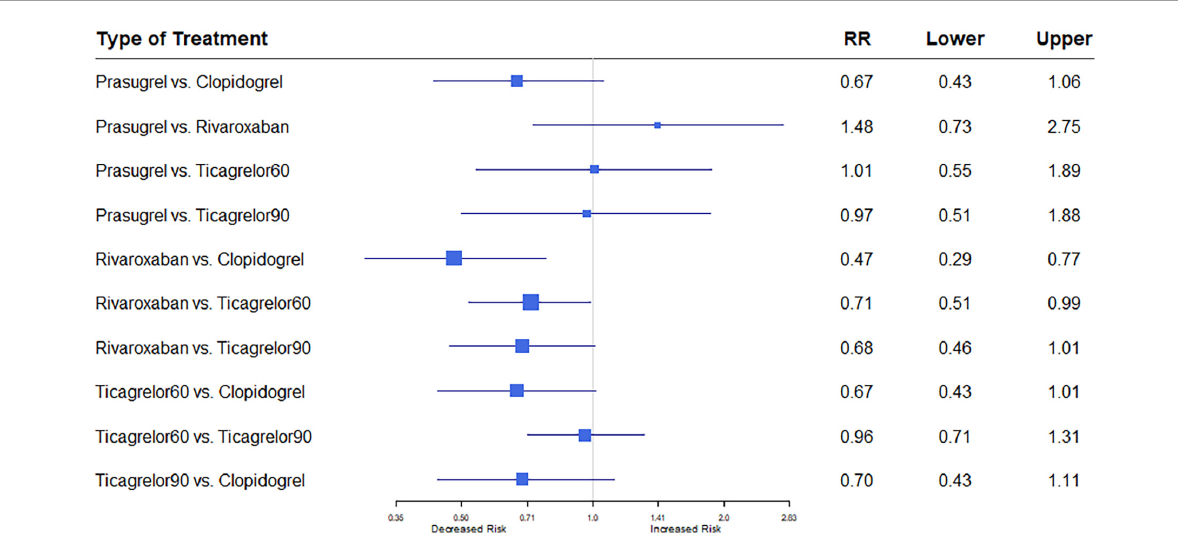
FIGURE5 A network meta-analysis of the association between anti-thrombotic therapy and stroke in patients with chronic coronary syndrome. Net-work Meta-analysis of the Association Between anti-thrombotic therapy and stroke. The size of squares is proportional to the weight of each study. Horizontal lines indicate the 95% CI of each treatment; diamond, the pooled estimate with 95% CI; and RR, relative risk.